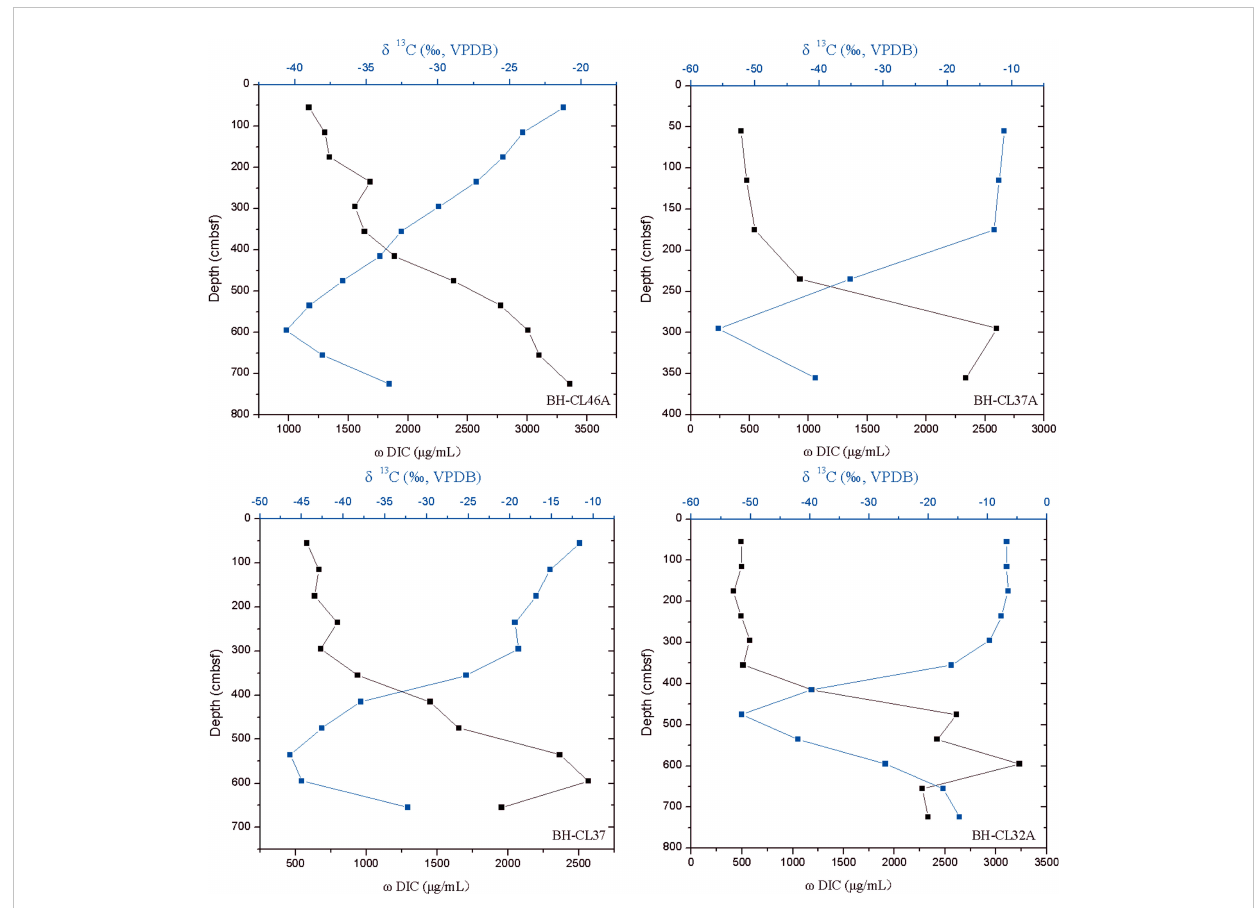
FIGURE 5 Depth pro fi les of DIC and d 13 C DIC in pore water of each sediment core.